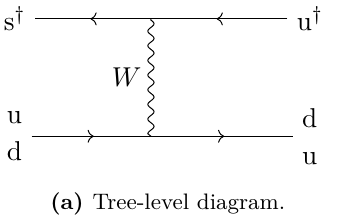
and O in (2.36a), while the penguin 1 2 to O in (2.36b) and (2.36c). Up-type quarks are collectively 3 6